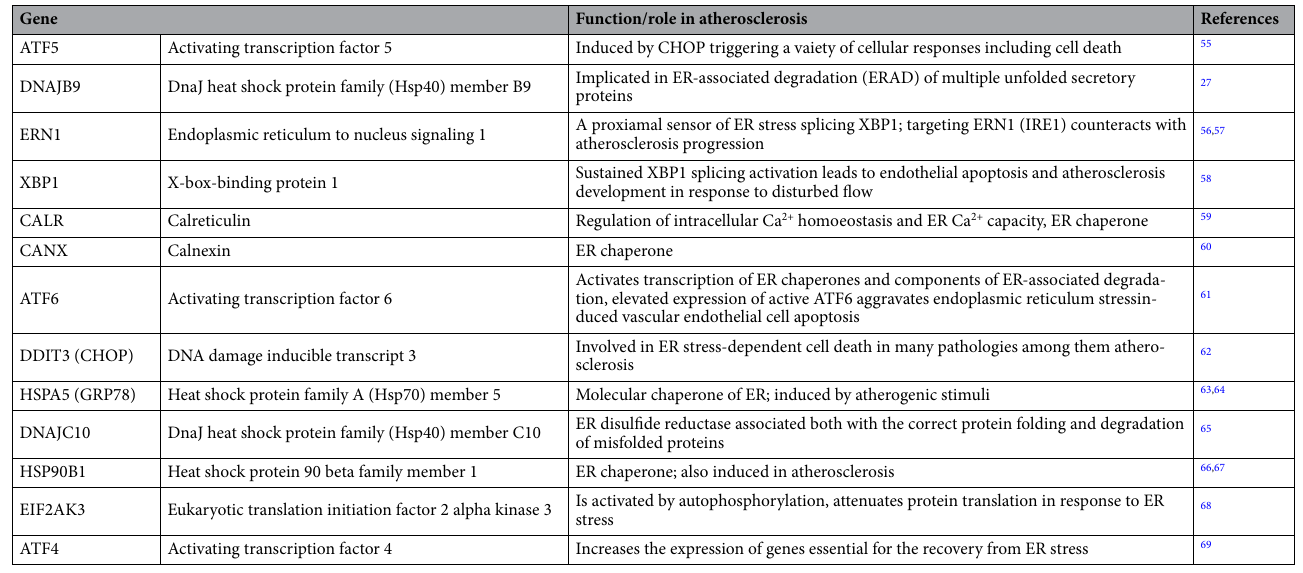
Table 1. The role of ER stress responsive proteins in